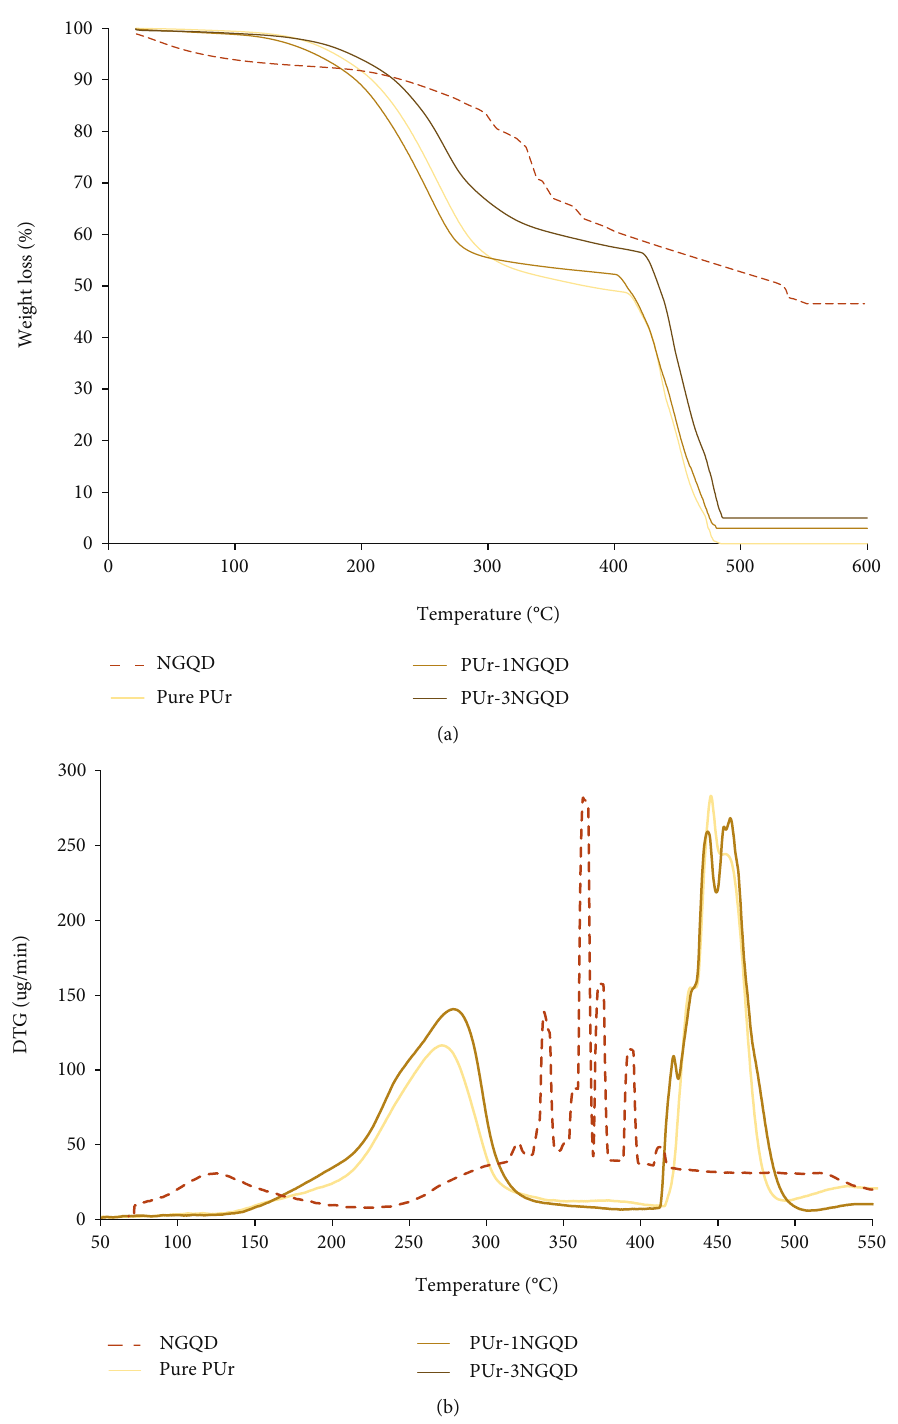
Figure 9: TGA/DTG Thermograms of NGQD nanoparticle, pure PUr, and PUr-NGQD nanocomposites. Table 2: Degradation data of PUr and PUr-NGQD